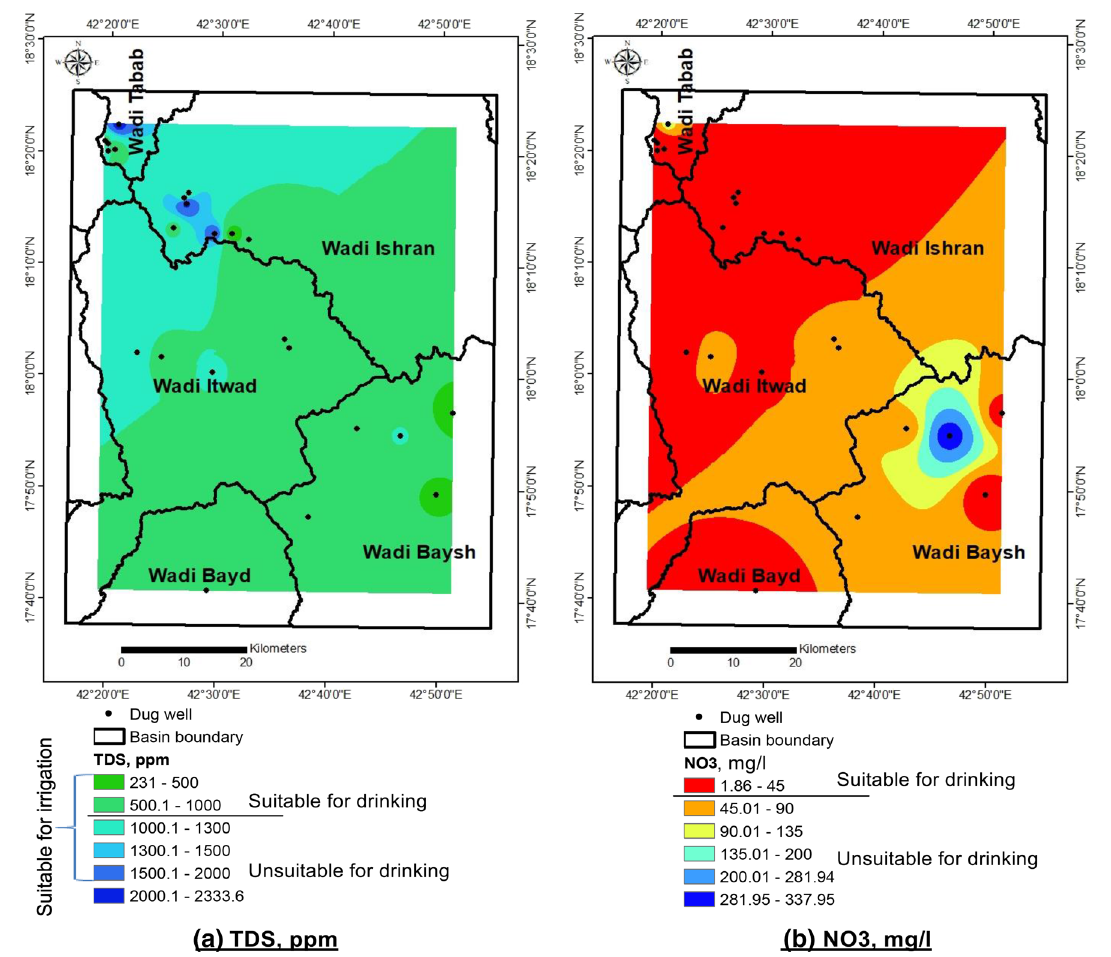
Fig. 13 a TDS and b NO 32− of the aquifer in the study